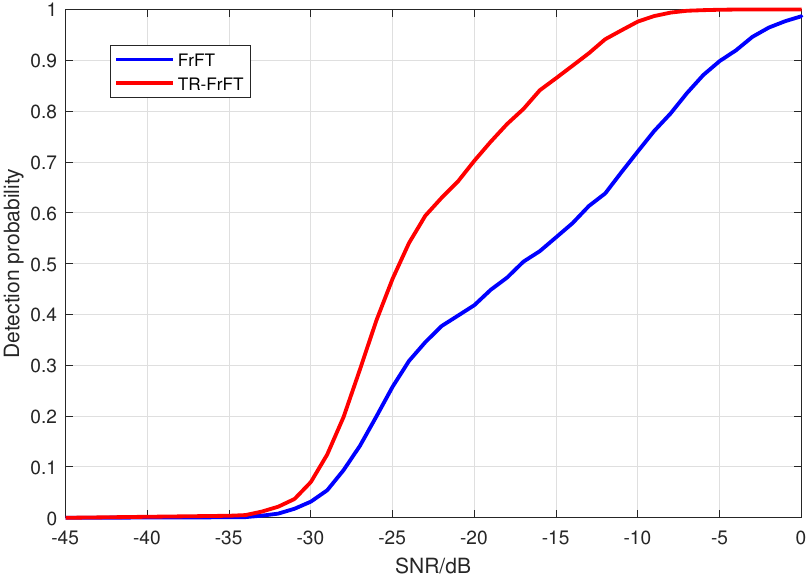
Figure 16. Detection probability vs. SNR for FrFT and TR-FrFT with the simulated data. The false alarm rate is P F = 0.1. The Doppler frequency shift is 80